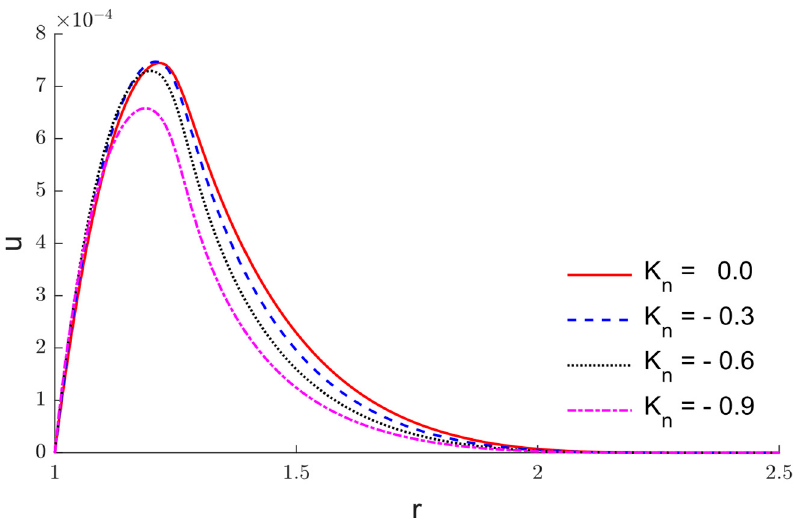
Figure 3. The variation of radial displacement u via r when τ o = 0.05 under varying thermal